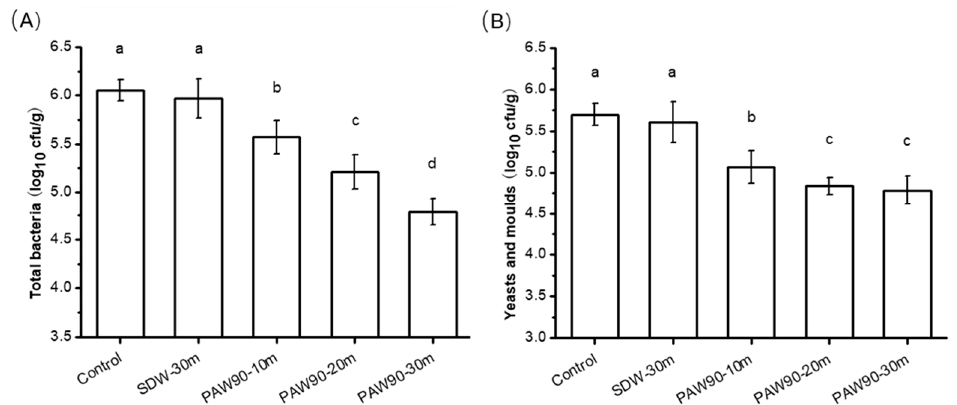
Figure 2. The numbers of surviving bacteria ( A ) and yeasts and molds ( B ) on thin sheets of bean curd before and after PAW treatments with different soaking times. Different letters in the bars indicate statistically significant differences ( p < 0.05).